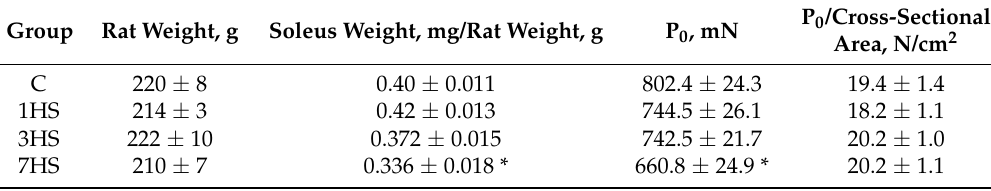
Table 1. Changes in rat’s body weight, soleus weight-to-body weight ratio and P 0 , and P 0 normalized to muscle cross-sectional area following 1-, 3- and 7 days of hindlimb